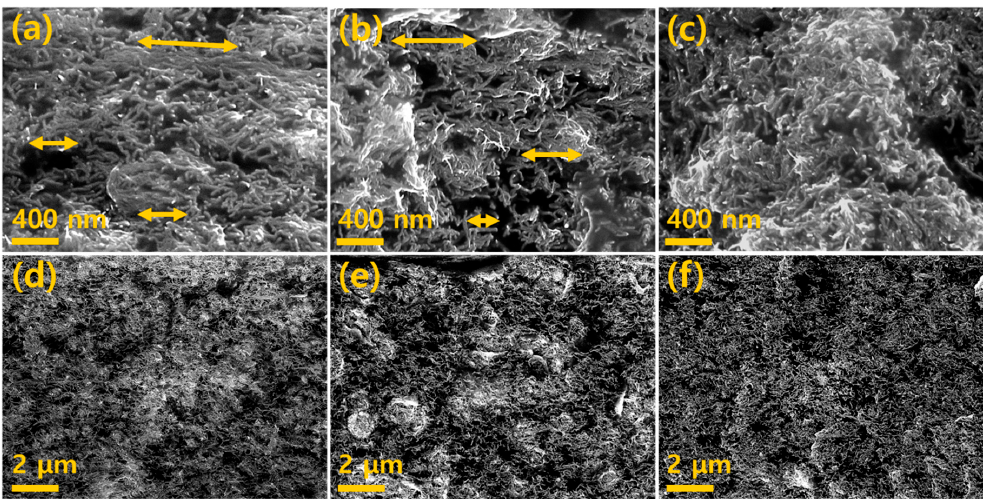
Figure 2. SEM cross-section images of: ( a ) and ( d ), aligned direction (R V = 4.5). ( b ) and ( e ), aligned direction (R V = 1.5). ( c ) and ( f ), random array MWCNT/PDMS composite film.